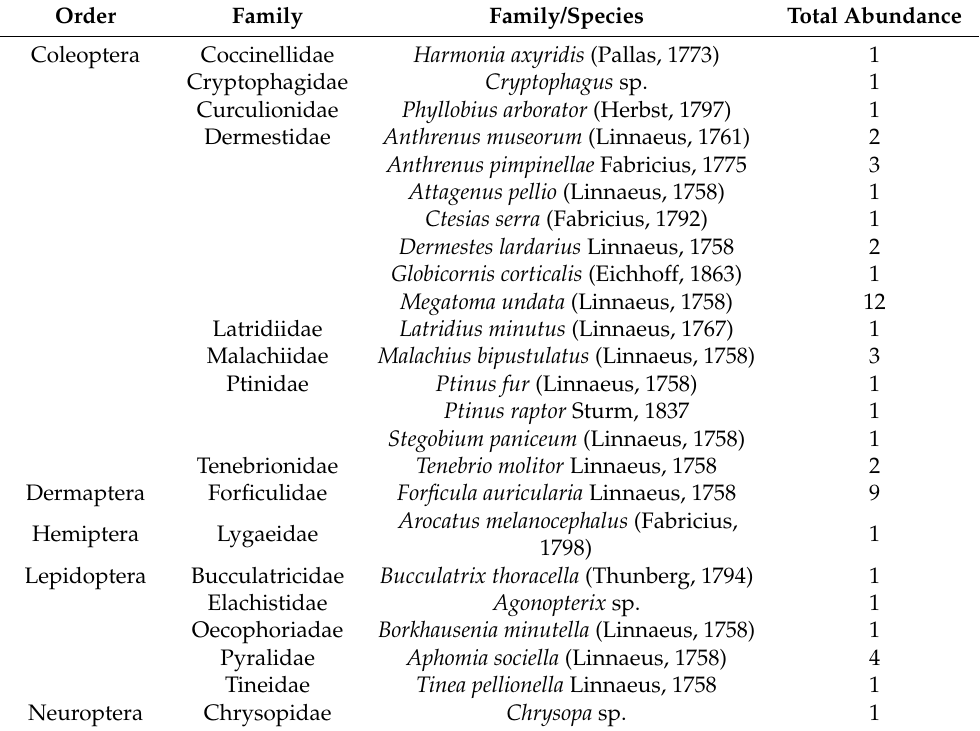
Table A2. Species of insects found in nesting material accumulated in the nest boxes occupied by the red squirrel in central Poland in the three habitats (continuous forest, habitat mosaic and urban park) in the years